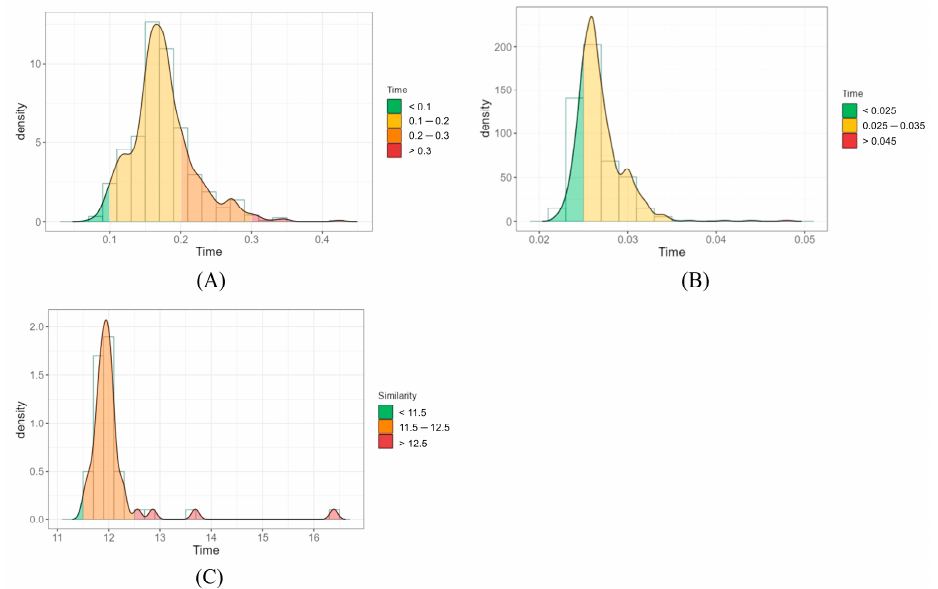
Figure 16. Time consumed by the conversion process. ( A ) Time consumed by feature point detection and sorting. ( B ) Time consumed by grouping. ( C ) Time consumed by reconstruction. Each x-axis was the elapsed time of the process (in seconds) and the y-axis was the data density. The smaller the value, the more efficient was the conversion.